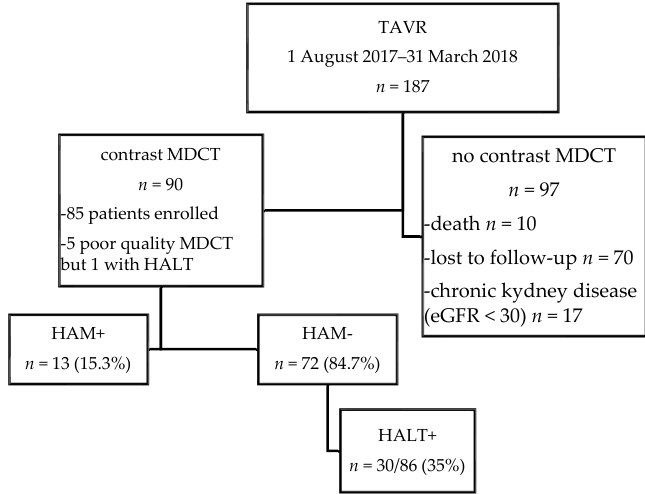
Figure 1. Flowchart of the study. Abbrevations: eGFR: estimated glomerular filtration rate; HAM: hypoattenution affecting motion; HALT: hypoattuated leaflet thickening; MDCT: multidetector computed tomography; TAVR: Transcatheter aortic valve replacement.